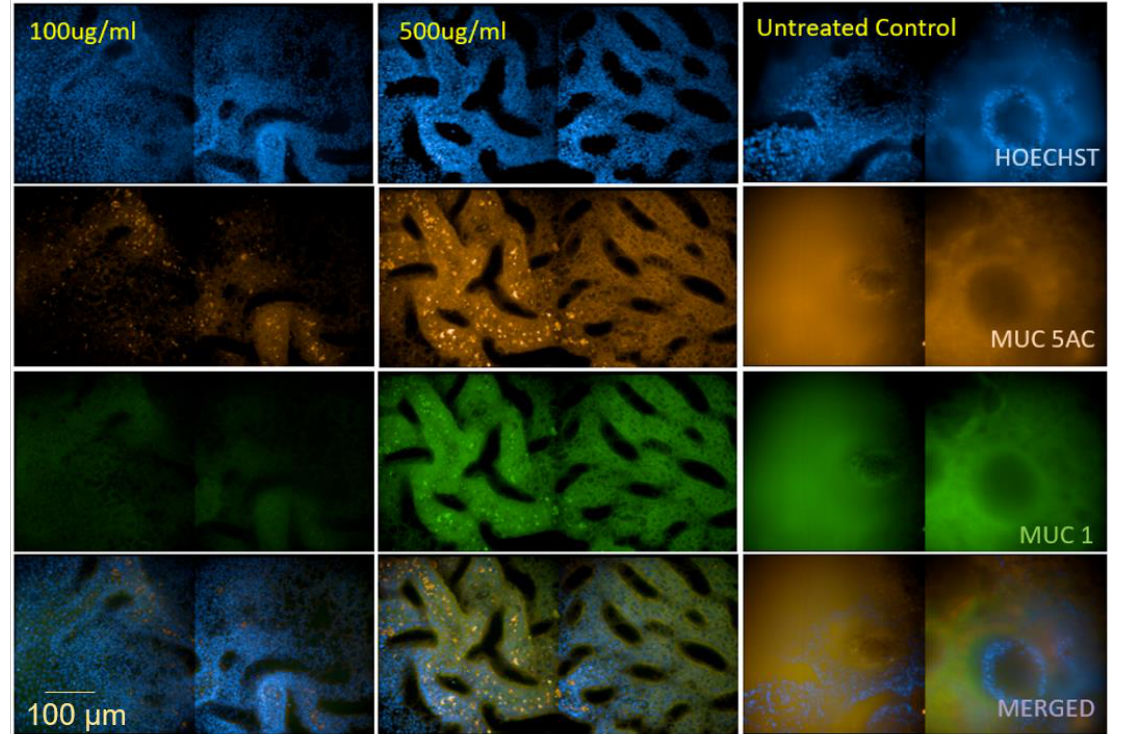
Figure 2. Dexamethasone reduces mucus production on airway epithelial cells. The respiratory 3D model was treated with dexamethasone (100 µg mL −1 and 500 µg mL −1 ) for 7 days. Following staining for MUC1-Alexa488 (green) and MUC5AC-Alexa555 (orange), phenotypic differences were assessed using confocal microscopy. Representative images of NHBE cells in ALI grown on collagen showing differences in MUC5AC and MUC1 expression, which was downregulated following dexamethasone treatment. Membranes were counterstained using Hoechst 33342 to highlight nuclei (blue). The experiment was independently repeated three times, and multiple fields were imaged.